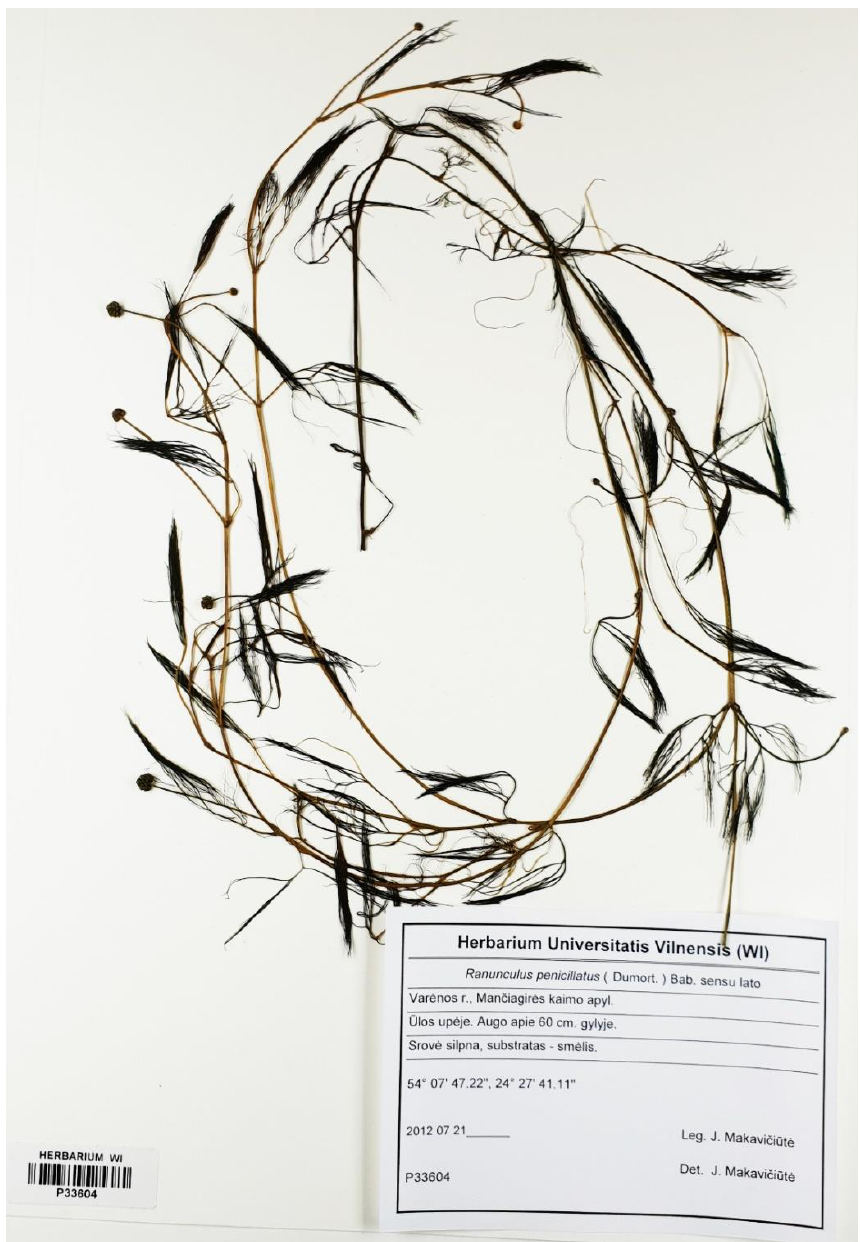
Figure 3. General appearance of putative Ranunculus penicillatus s.l. plant with capillary leaves only, from the Ula River.